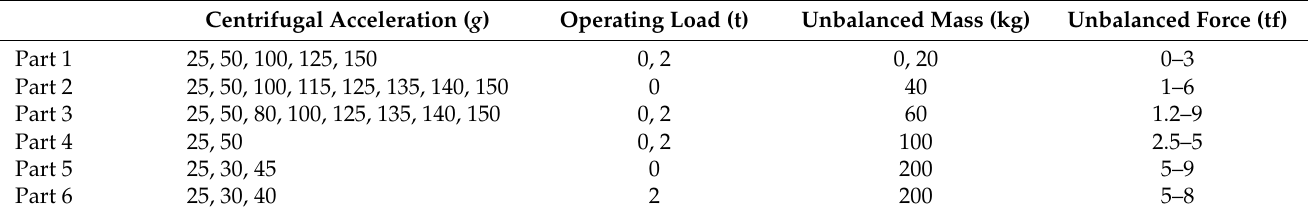
Table 1. Experimental conditions and unbalanced force range for the training dataset.